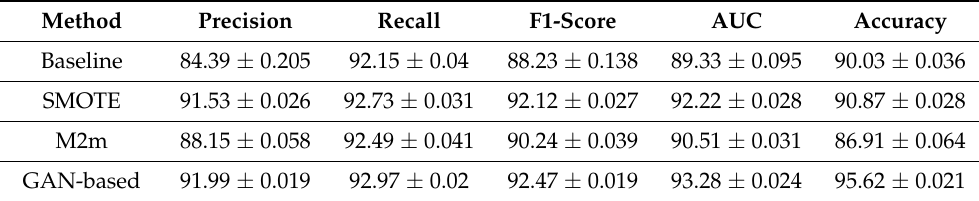
Table 3. Performance metrics of the class imbalance techniques with 60% healthy plants and 40% diseased plants (Average for 10-fold cross